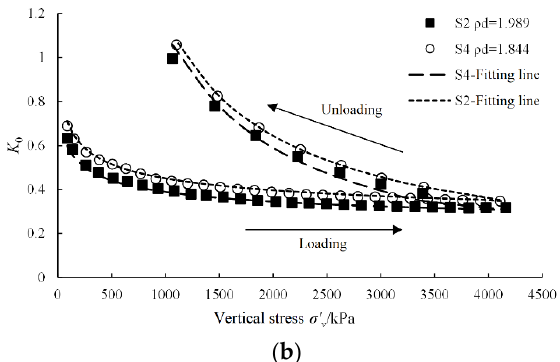
Figure 3. K 0 – σ 1 curves with di ff erent p d : ( a ) S1 and S3; ( b ) S2 and S4. To verify the applicability of Equation (1) for dense coarse-grained soil, Equation (1) was adapted to fi t the test results of S1~S4, for which the fi tt ing parameters are listed in Table 2, while the fi tt ing curves are given in Figure 4. Figure 4 shows that the fi tt ing curve and experimental results are in good agreement. Speci fi cally, compared to the corresponding test data, the average error of the fi tt ing data for Equation (1) is less than 5%, while the maximum error is less than 14%. As discussed above, it is clear that Equation (1) can also be adopted to describe the K 0 behavior of compacted coarse-grained soil. Table 2. K 0max and K 0min of the tested specimens. Fitting Parameters